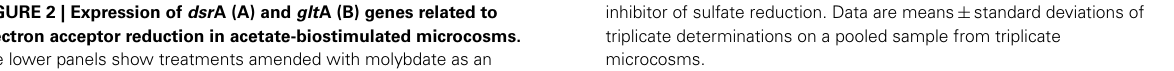
inhibitor of sulfate reduction. Data are means ± standard deviations of triplicate determinations on a pooled sample from triplicate